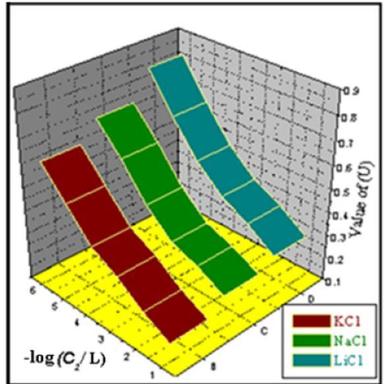
The plot of (U) value against logarithm of concentration of PVC–NP composite membrane.